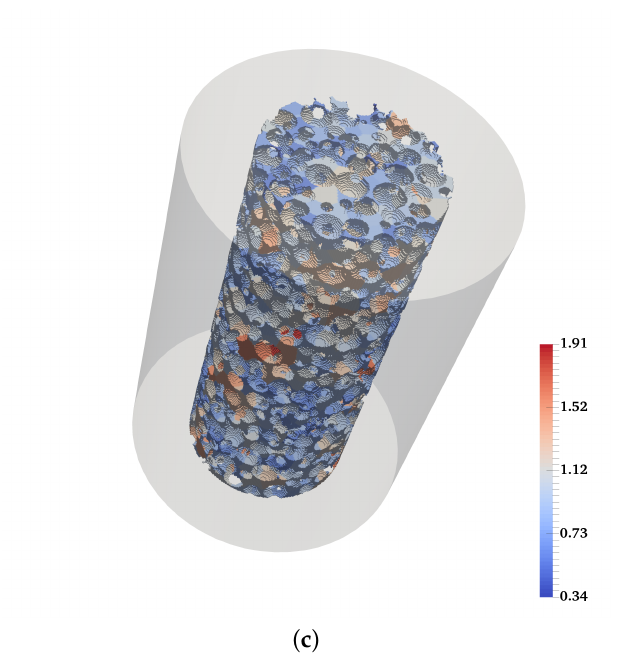
Figure 14. Pore segmentation visualization and PSD for multi-sized packed spheres inside a cylindrical container (color coded according to normalized pore size). ( a ) PSD with and without boundary effects; ( b ) segmented pores with boundary effects; ( c ) segmented pores without boundary affected